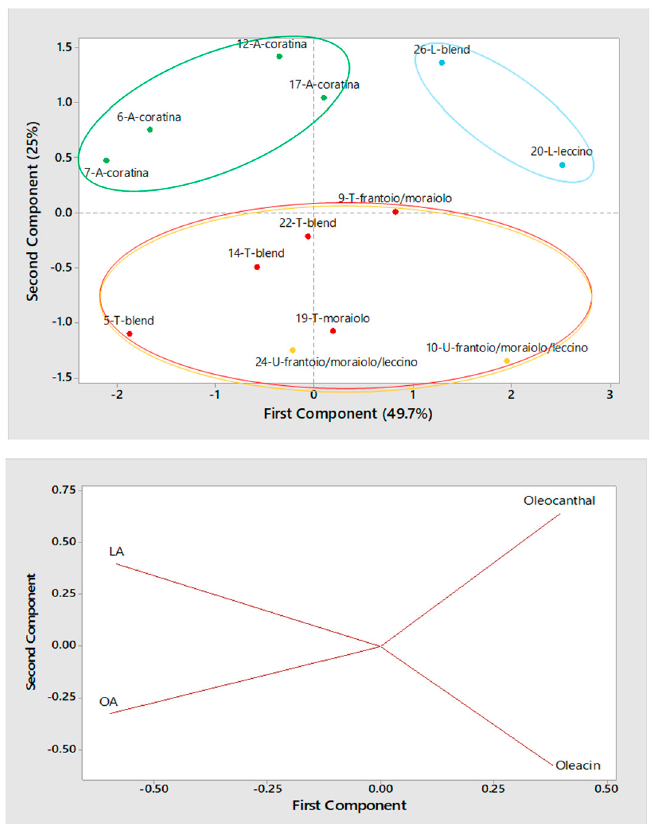
Figure 6. Score plot ( top panel ) and Loading plot ( bottom panel ) referred to the first two components provided by Principal Components Analysis (PCA) based on average normalized peak areas obtained for OA, LA, oleacin and oleocanthal (including the contribution of their carboxylic derivatives, if present) after the RPLC-ESI(-)-FTMS analysis of two replicated extracts for each of 13 Italian EVOOs produced during the 2016/2017 campaign using a two-phase decanter for horizontal centrifugation. Samples are labelled according to number (see Table 1), region (A = Apulia, L = Lazio, T = Tuscany, U = Umbria) and cultivar.